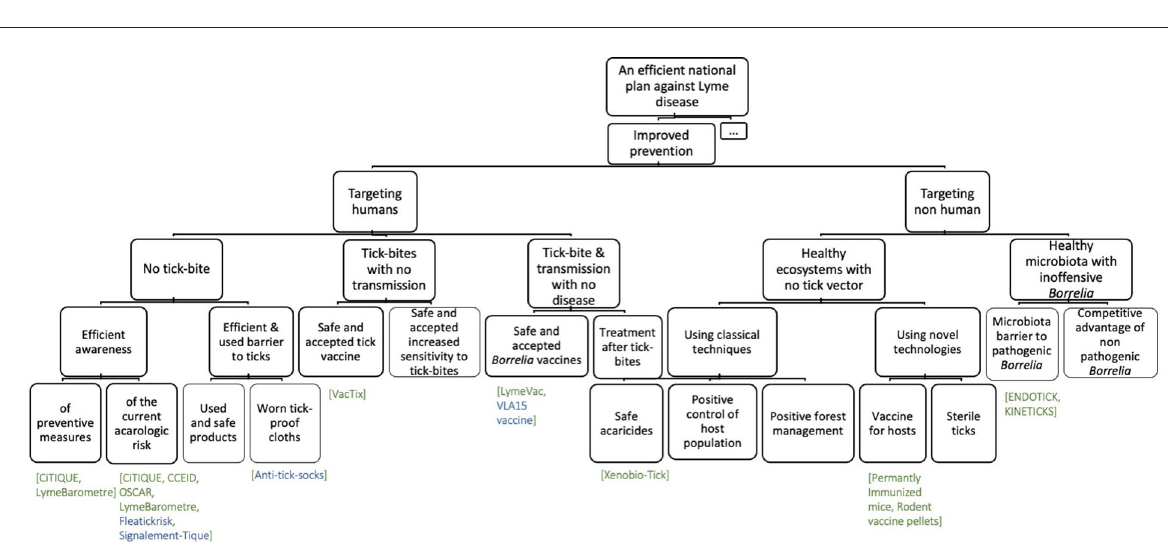
to the difficulty of raising ticks, the important diversity of hosts and bacteria reservoirs and the complexity of the bacteria’s ecosystem. Thus, the CK diagram evolved from CK0 with splitting with action on humans or other than humans and